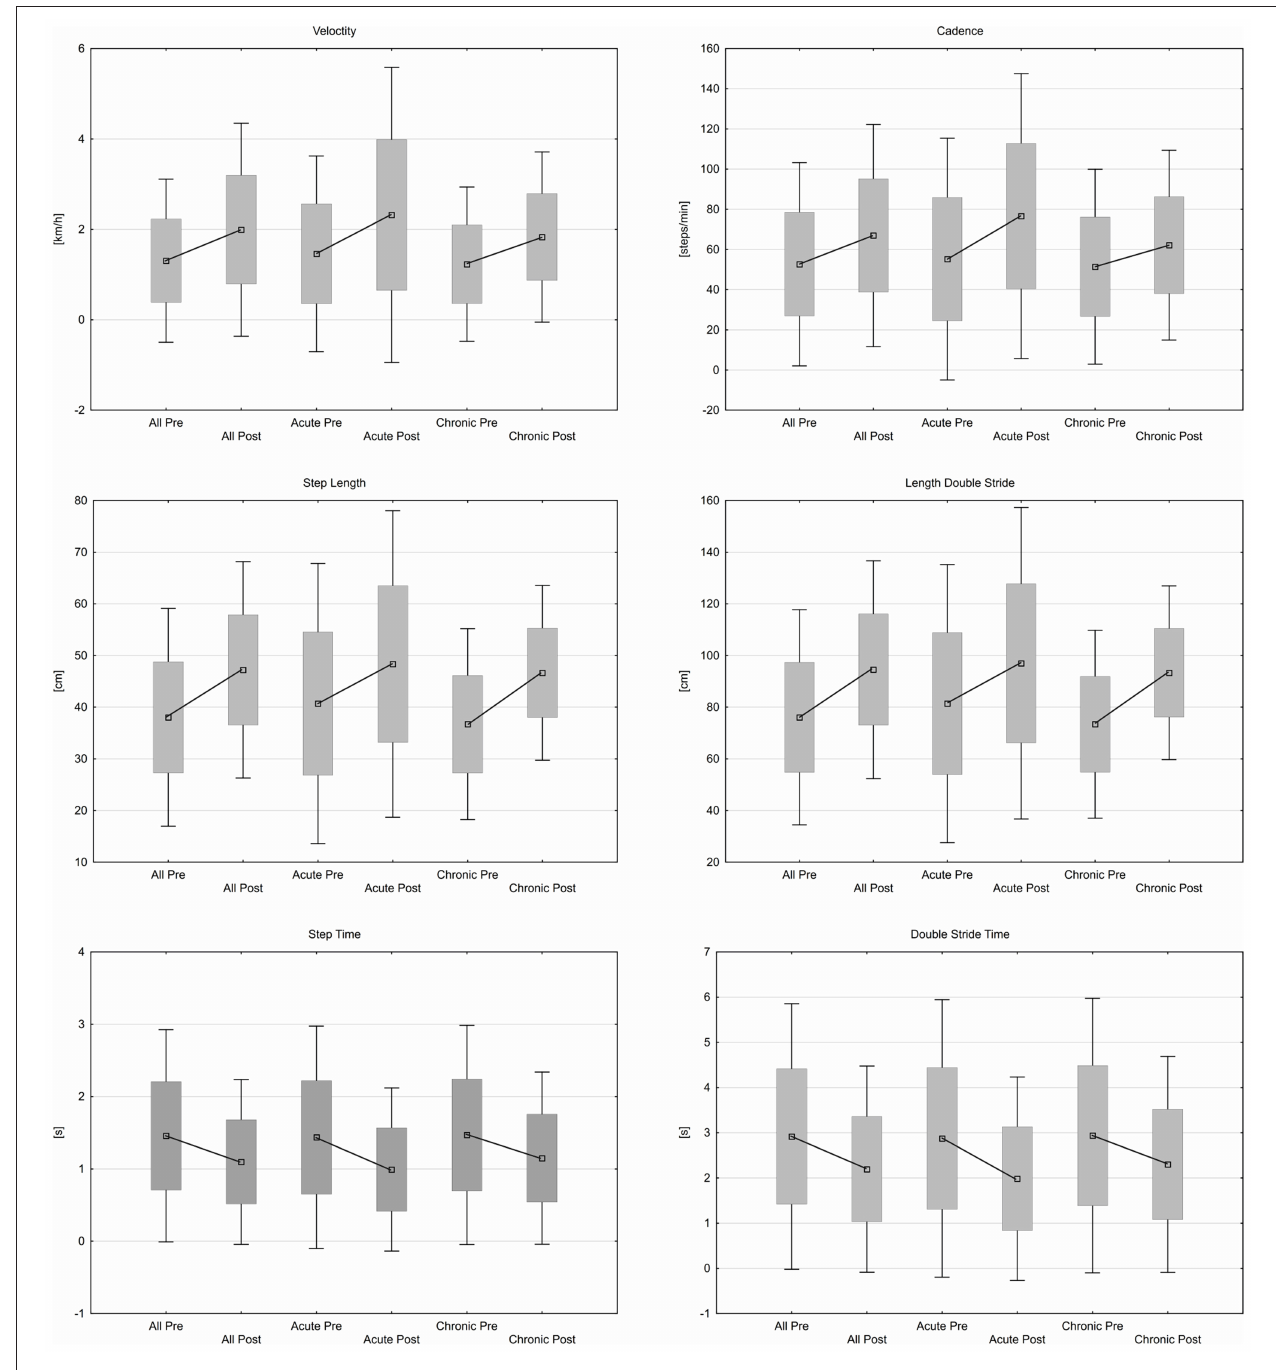
FIGURE 2 | Spatiotemporal